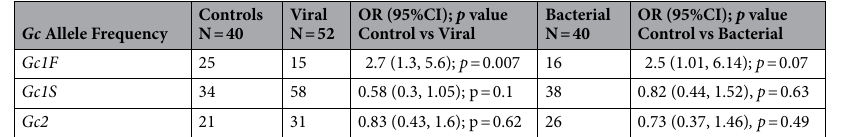
Table 3. Allele frequencies of Gc gene between infants with viral infection compared to controls and between infants with bacterial infection and controls.